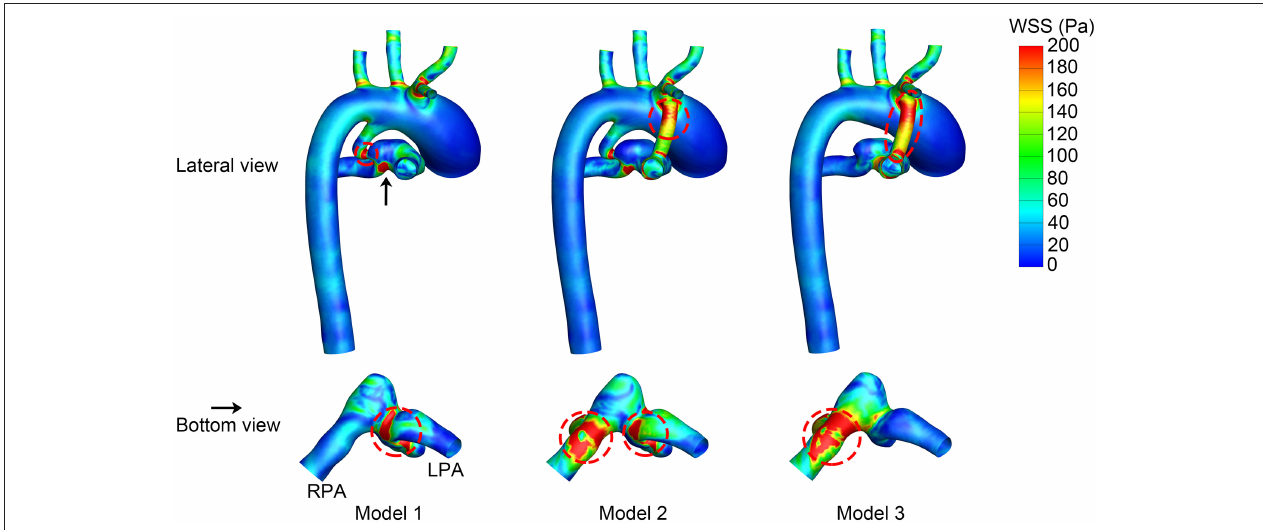
FIGURE 4 | Wall shear stress (WSS) at the systolic peak. The upper row is the lateral view of the whole model, and the lower row is the bottom view of the model except for the aorta. The black arrow indicates the perspective of the bottom view. Areas with high WSS are marked in a red dashed circle. LPA, left pulmonary artery; RPA, right pulmonary